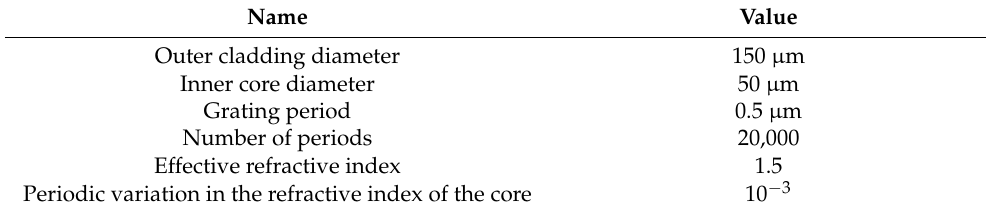
Table 1. FBG sensor parameters.